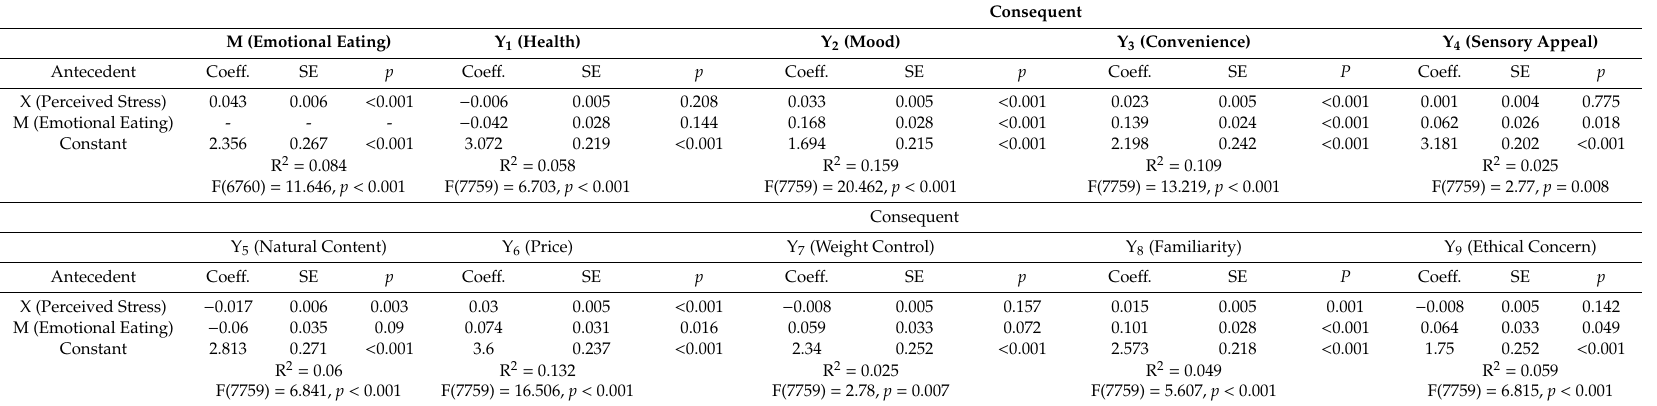
Table 3. Model coe ffi cient estimations for mediation